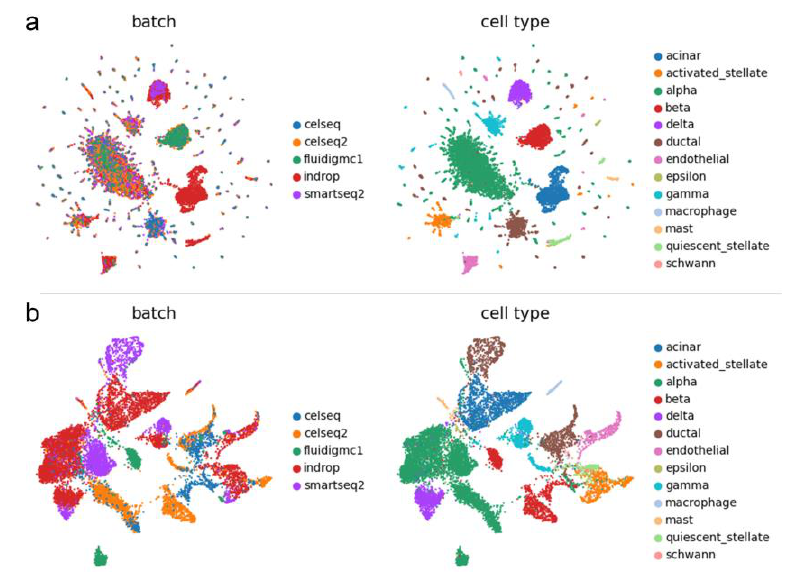
Figure 11. UMAP visualization of the data after AE and GAN correction on the Pancreas-subset dataset. ( a ) AE, ( b ) GAN.